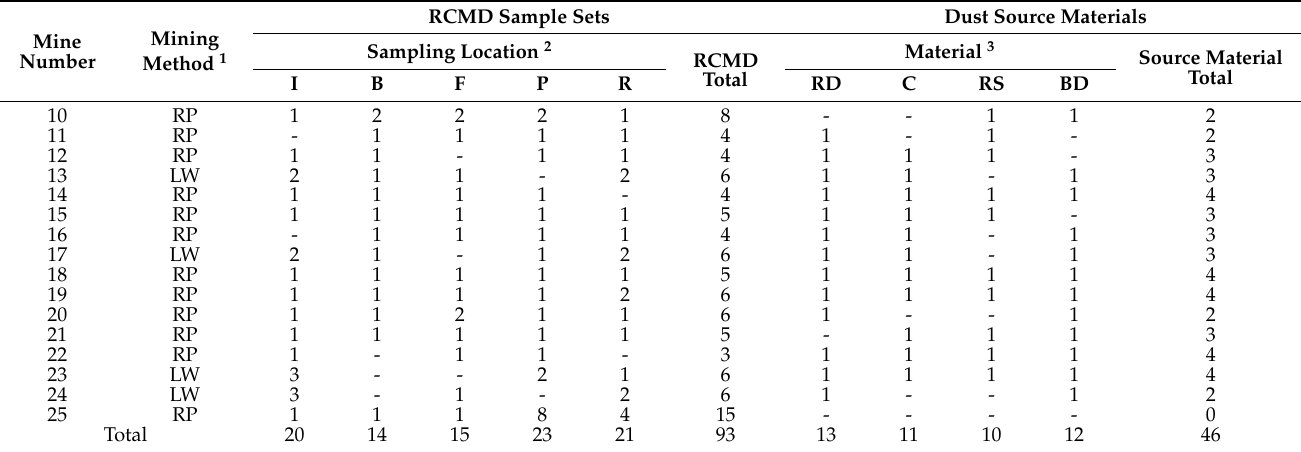
Table 1. Number and location of RCMD sample sets and dust source materials collected in the 16 underground coal mines included in this study. Descriptions of sampling locations are provided in Table 2.